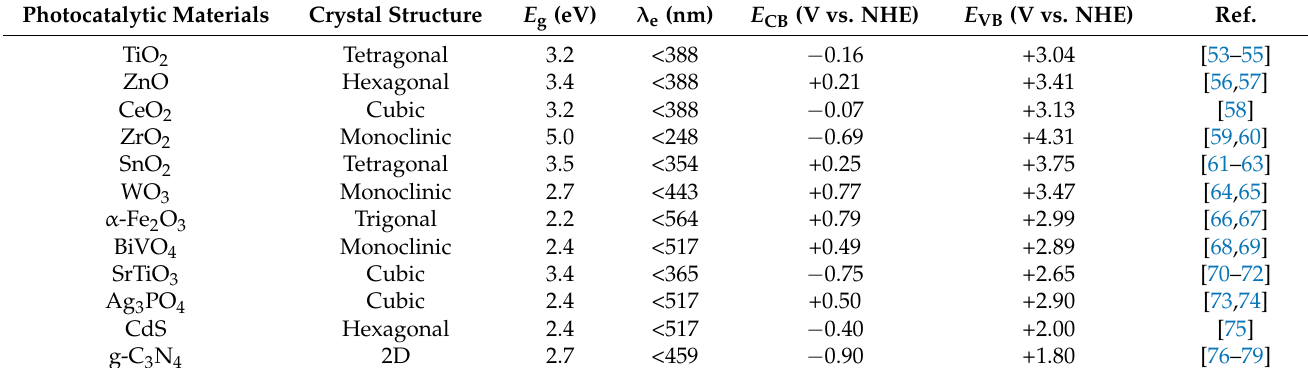
Table 1. Crystallographic and electronic properties of common photocatalytic materials.